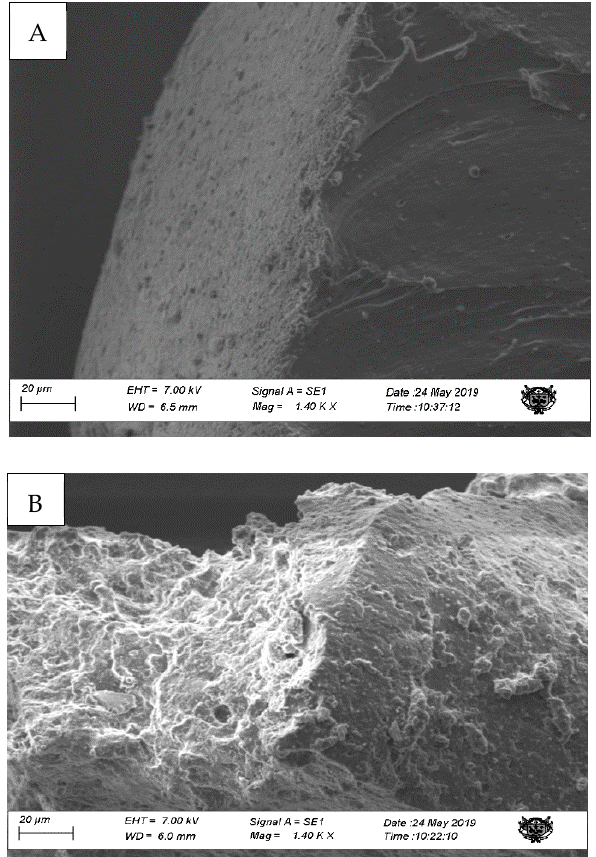
Figure 3. ( A ) Non-degraded rubber matrix, ( B ) degraded matrix—1.40 KX.